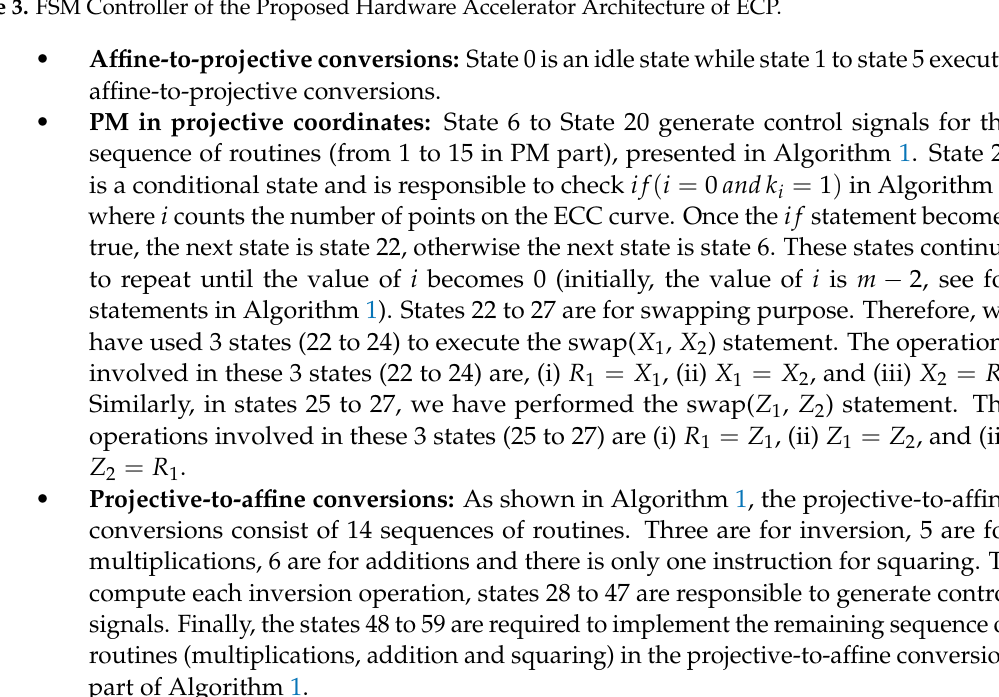
Figure 3. FSM Controller of the Proposed Hardware Accelerator Architecture of